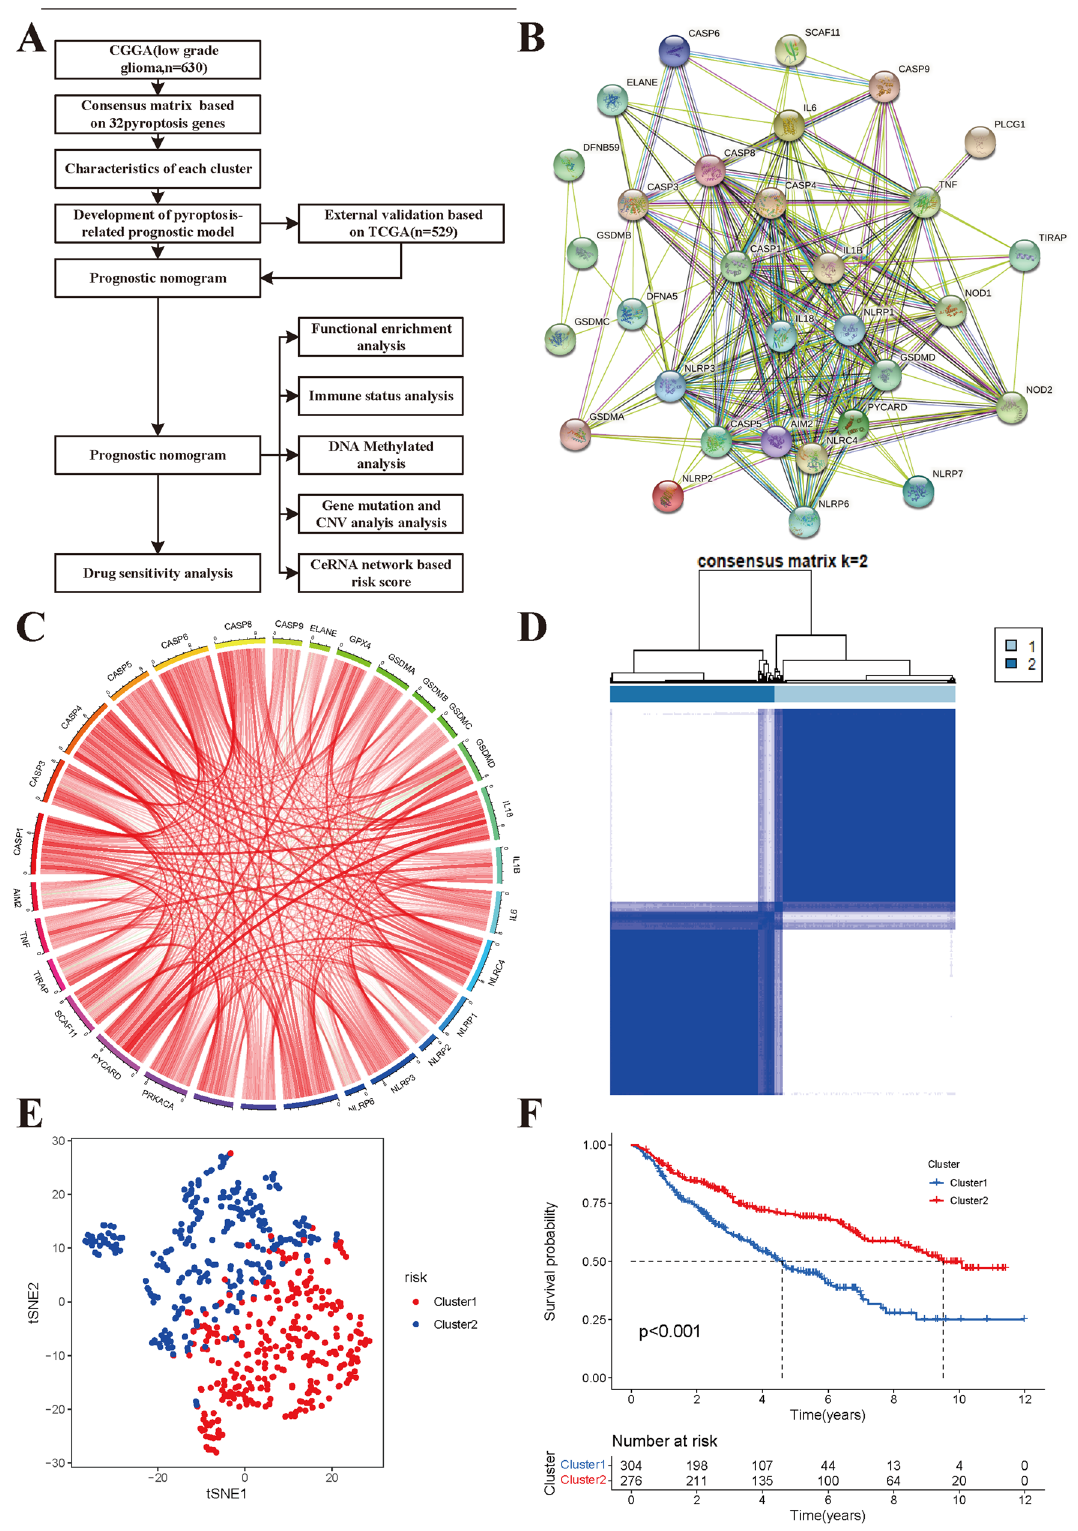
Figure 1. Consensus clustering identifies the molecular subtype of low-grade glioma using CGGA dataset. ( A ) Flow diagram of integrated analysis in the study. ( B ) Protein–protein interaction network of identified pyroptosis in the STRING. ( C ) The positive (red) and negative (green) correlations of pyroptosis genes using Spearman method. ( D ) Consensus clustering identified optimal number of molecular subtypes for low-grade glioma (k = 2). ( E ) The tSEN2 analysis revealed the marked two subclasses in low-grade glioma. ( F ) Kaplan– Meier survival curves of two subclasses (blue: cluster 1; red: cluster